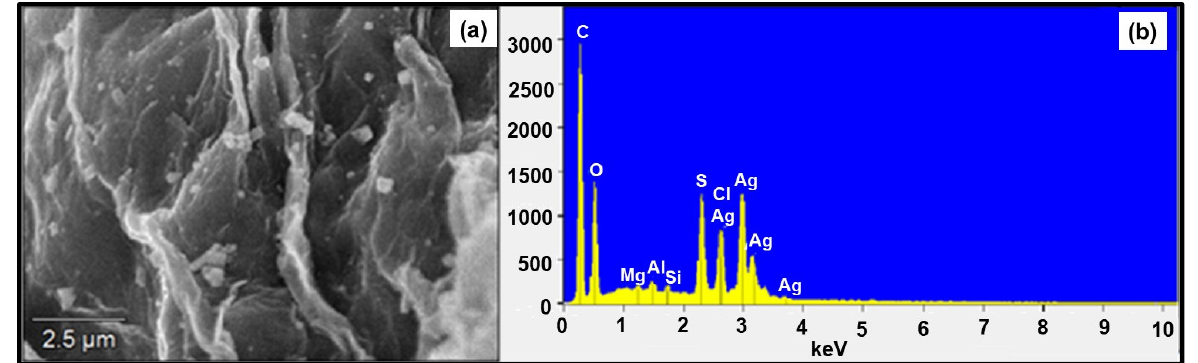
Figure 1. FTIR spectra of CS, FL-CS, GO-FL-CS, and Ag NPs@GO-FL-CS.